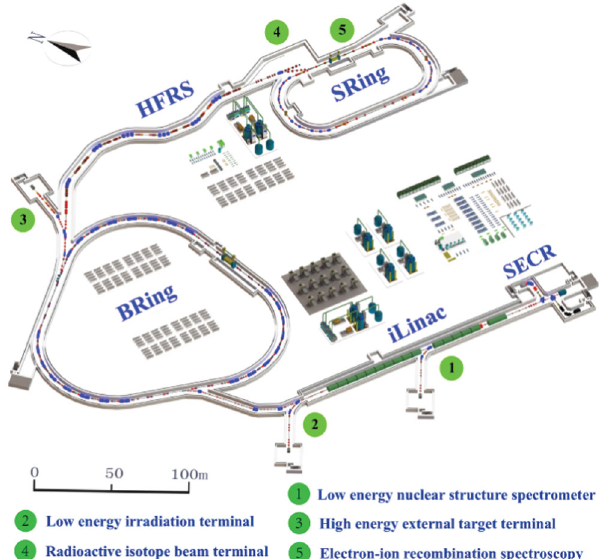
FIG. 1. The layout of the HIAF